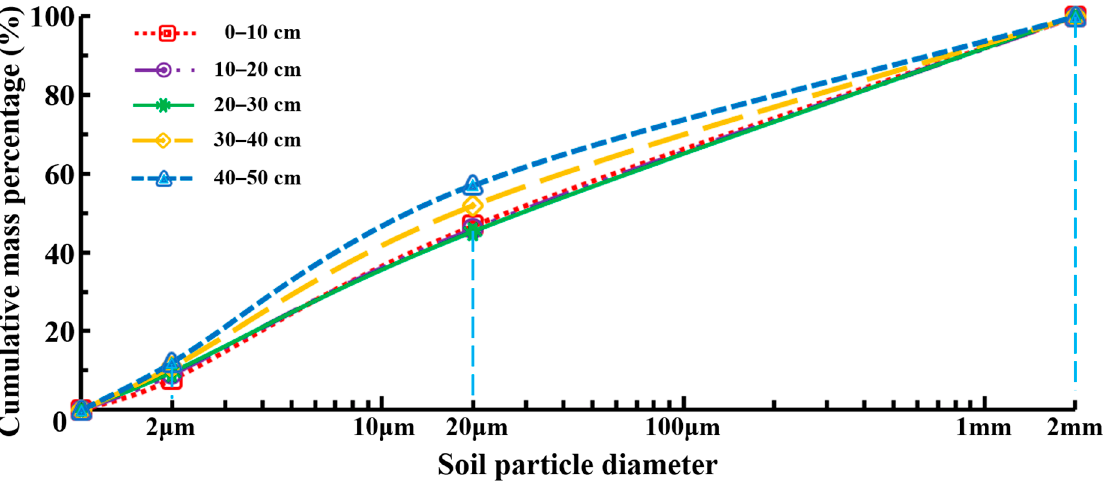
Figure 8. The cumulative mass percentage of soil particle size distribution.